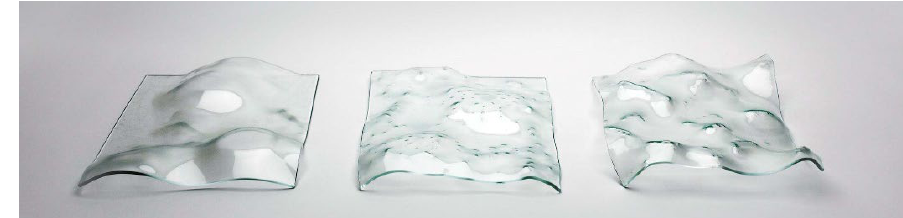
Fig. 2: Glass shaped onto fine silica sand, gravel, and rocks (from left to right).